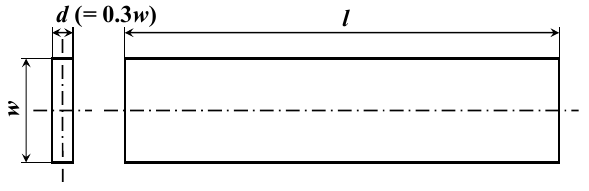
Fig. 1 Tumbling plate; a prism with a rectangular cross section.